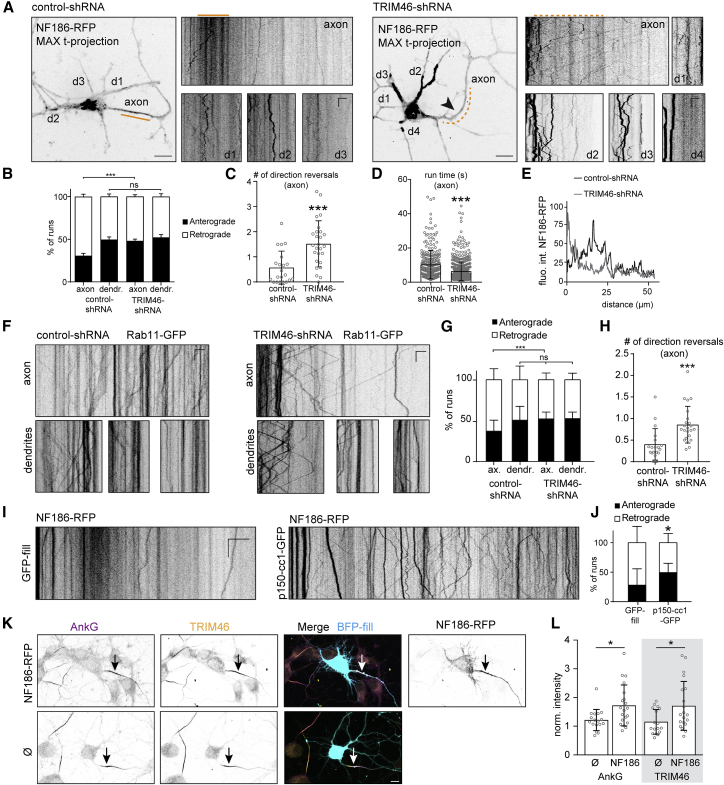
TRIM46 Promotes Retrograde Transport of NF186 to the Proximal Axon(A) Maximum time projection from time-lapse imaging of DIV4 neurons transfected at DIV0 with indicated constructs. Kymographs of axon and dendrites are shown. Orange lines highlight the proximal axon. Scale is 5 μm (horizontal) and 15 s (vertical).(B) Percentage of NF186-RFP runs in DIV4 neurons co-transfected at DIV0 with indicated constructs. n = 20 neurons, N = 2, 2-way ANOVA, ∗∗∗p = 0.0002, ns: p = 0.916.(C and D) Quantification of NF186-RFP vesicle dynamics in DIV4 neurons co-transfected at DIV0 with indicated constructs. Mann-Whitney in (C), p = 0.0003, n = 21–26 axons, and in (D), p < 0.0001, n = 279–645 runs.(E) Fluorescence intensity profiles of NF186-RFP along the axons of neurons shown in (A).(F–H) Kymographs (F) of Rab11-GFP vesicles in DIV3 neurons co-transfected at DIV0 with indicated constructs. Scale is 5 μm (horizontal) and 3 s (vertical). (G) Percentage of runs. (H) Mean number of direction reversals per axon. n = 18 neurons, N = 2. In (G), two-way ANOVA, ns p = 0.5, ∗∗∗p < 0.001. In (H), Mann-Whitney test, ∗∗∗p = 0.00012.(I and J) Kymographs (I) of NF186-RFP in the axons of DIV3 neurons co-transfected at DIV0 with indicated constructs. Scale is 10 μm (horizontal) and 5 s (vertical). (J) Percentage of runs. Two-way ANOVA, ∗p = 0.0104, n = 20 neurons, N = 2.(K and L) DIV5 hippocampal neurons (K) co-transfected at DIV1 with indicated constructs and stained for AnkG and TRIM46. (L) Intensity of AnkG and TRIM46 staining at the AIS normalized to neighboring non-transfected neurons. One-way ANOVA with Holm-Sidak’s multiple comparison test, p = 0.037 for AnkG, p = 0.020 for TRIM46. n = 17 neurons, N = 2.Scale bars are 10 μm in (A) and (K). See also Figure S6.